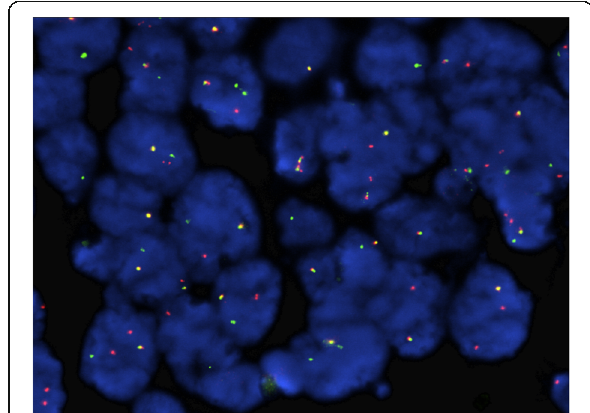
Fig. 2 Fluorescence in situ hybridization (FISH) for KMT2A (MLL ) rearrangement. FISH analysis using KMT2 A dual color break apart probe was performed on formalin fixed paraffin embedded tissue section. The tumor cells demonstrated separation of the signals indicating KMT2A gene rearrangement in 179 of 200 cells analyzed